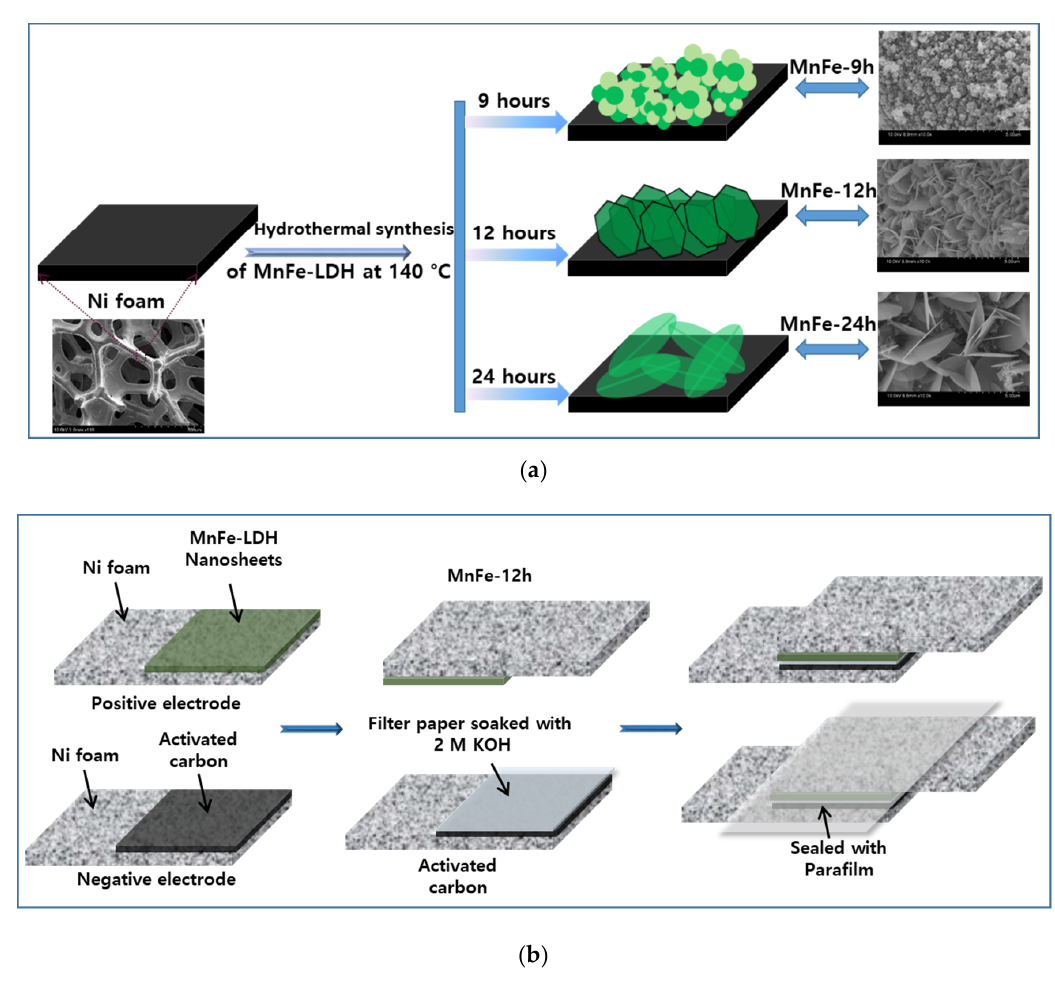
Figure 1. Schematic illustrations of the ( a ) stepwise growth process of MnFe hydroxide nanostructures controlled by the hydrothermal reaction time. ( b ) Fabrication of the asymmetric cell device.